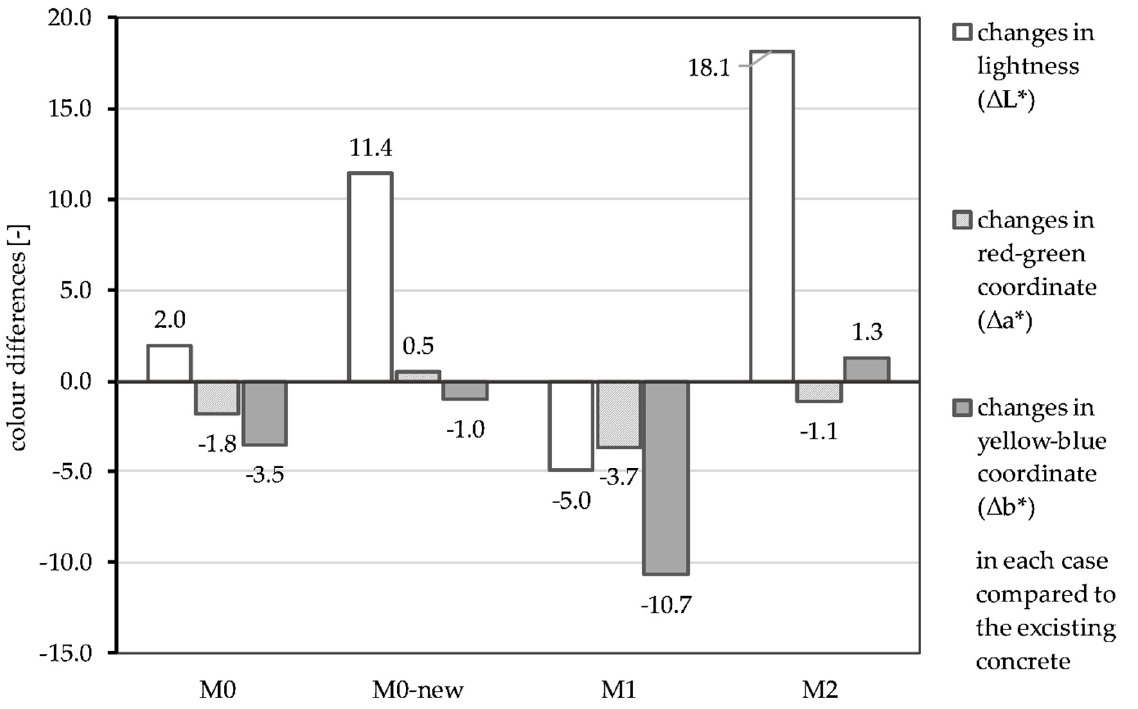
Figure 5. Colour differences of the investigated mortar mixtures (M1 and M2) in comparison with the existing concrete and the previously applied repair materials (M0 and M0-new) (mean values of ≥ 2 measuring stations with ≥ 5 measuring points).